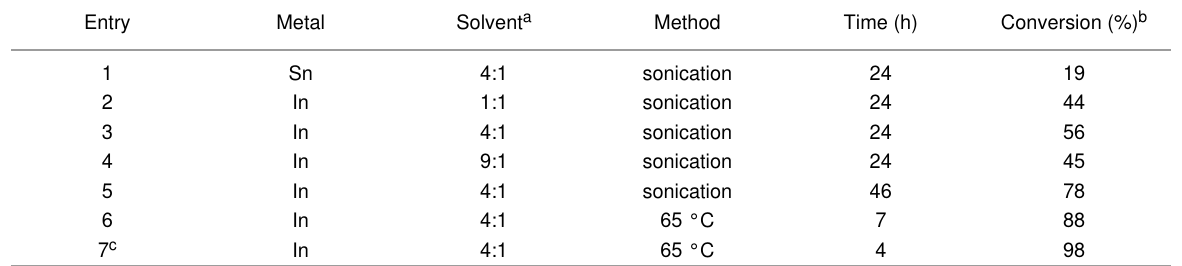
Table 1: Optimization of the reaction conditions of the indium-mediated allylation of melibiose.